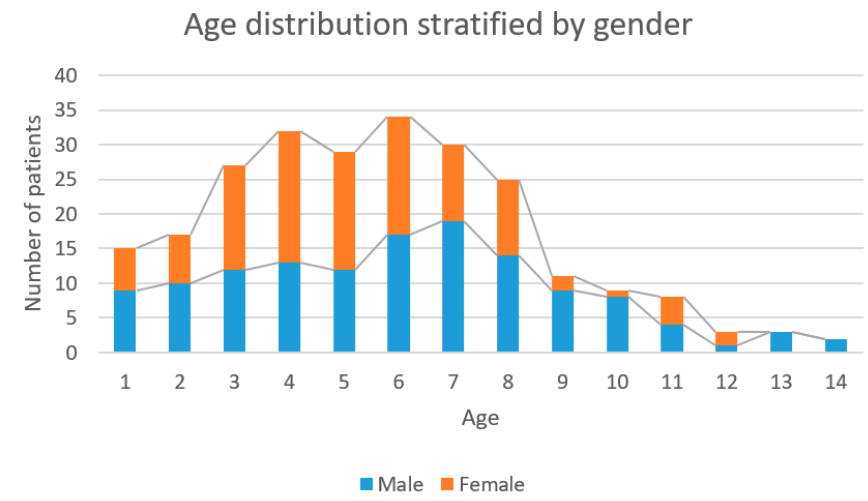
Figure 2. Age distribution stratified by gender.